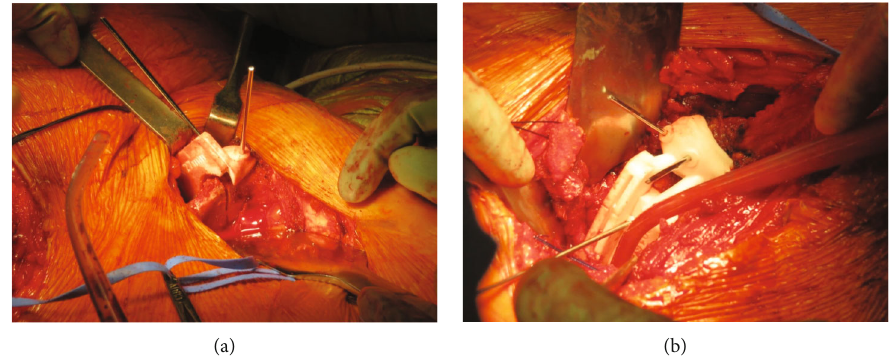
Figure 6: Intraoperative pictures showing the positioned cutting guide for the osteotomy of the iliopubic ramus (a) and the anterior-superior portion of the acetabulum (b).